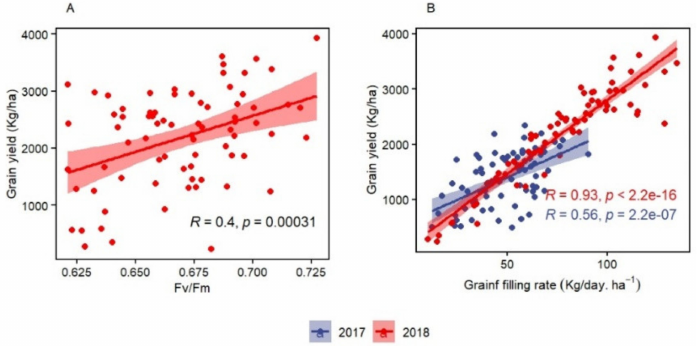
Figure 8. Linear regression and the Pearson correlation coefficient of maximum quantum yield of PSII (Fv/Fm) ( A ) and grain filling rate ( B ) versus grain yield under continuous heat stress for two seasons (2016–2017 and